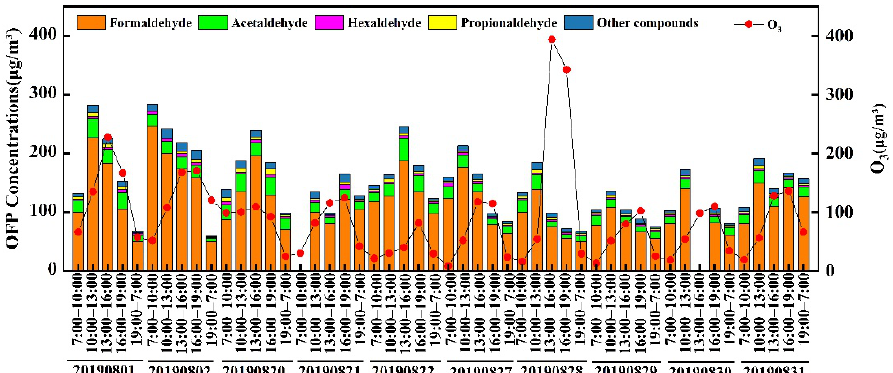
Figure 6. Time series of ozone formation potential (OFP) of carbonyls during the sampling period in summer.